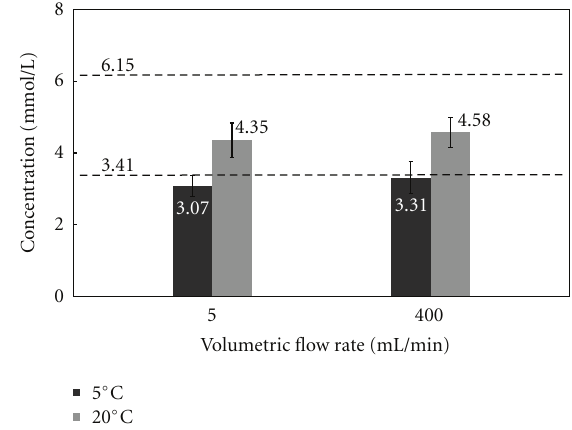
Figure 2: Acetone test gas concentration sampled from the bubbler system and calculated concentrations from Table 2.